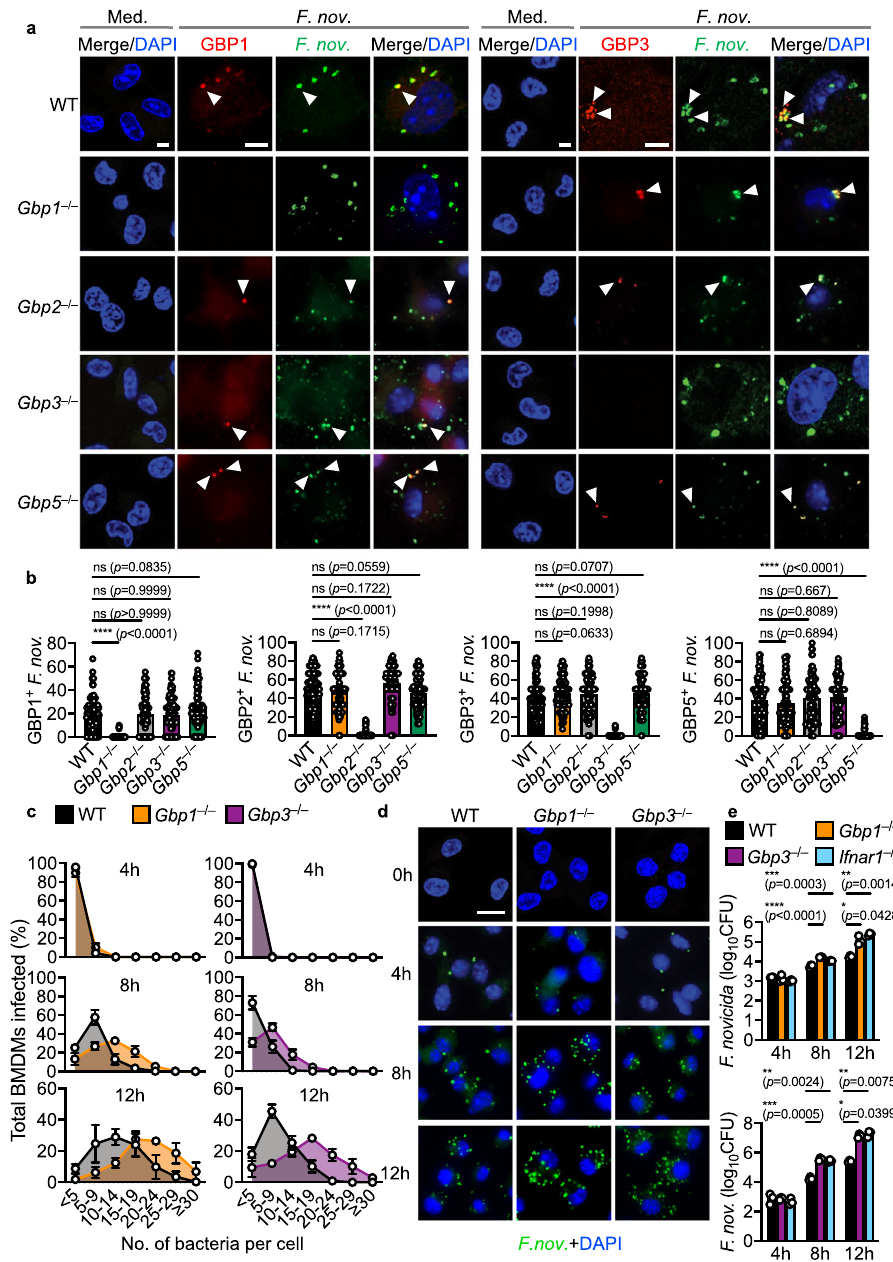
Fig. 2 | GBP1 and GBP3 target intracellular F. novicida and restrict its growth. a Confocalmicroscopyanalysisof F.novicida (green)and GBP1 (red)orGBP3(red) in WT, Gbp1 – / – , Gbp2 – / – , Gbp3 – / – and Gbp5 – / – BMDMs left untreated (Med.) or assessed 20h after infection with F. novicida (MOI 20). White arrows indicate bacteriacolocalizedwithGBP. b QuantitationofGBP1-,GBP2-,GBP3-,GBP5-positive F.novicida inWT, Gbp1 – / – ,Gbp2 – / – , Gbp3 – / – and Gbp5 – / – BMDMsastreatedin a . c The percentages of WT and Gbp1 – / – BMDMs (left) or WT and Gbp3 – / – BMDMs (right) harboring different number of bacteria. d Confocal microscopy analysis of F. novicida (green)andDNA(blue)inWT, Gbp1 – / – and Gbp3 – / – BMDMs0,4,8,and12h